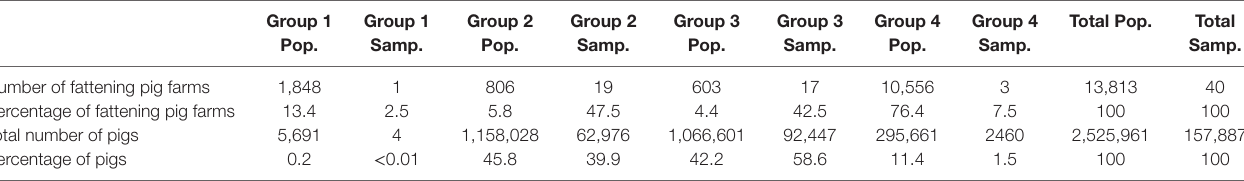
TaBle 2 | Number of farms and number of pigs per classification group a in the whole population (Pop.) and in the study sample (Samp.) of fattening pig farms. group 1 group 1 Pop.